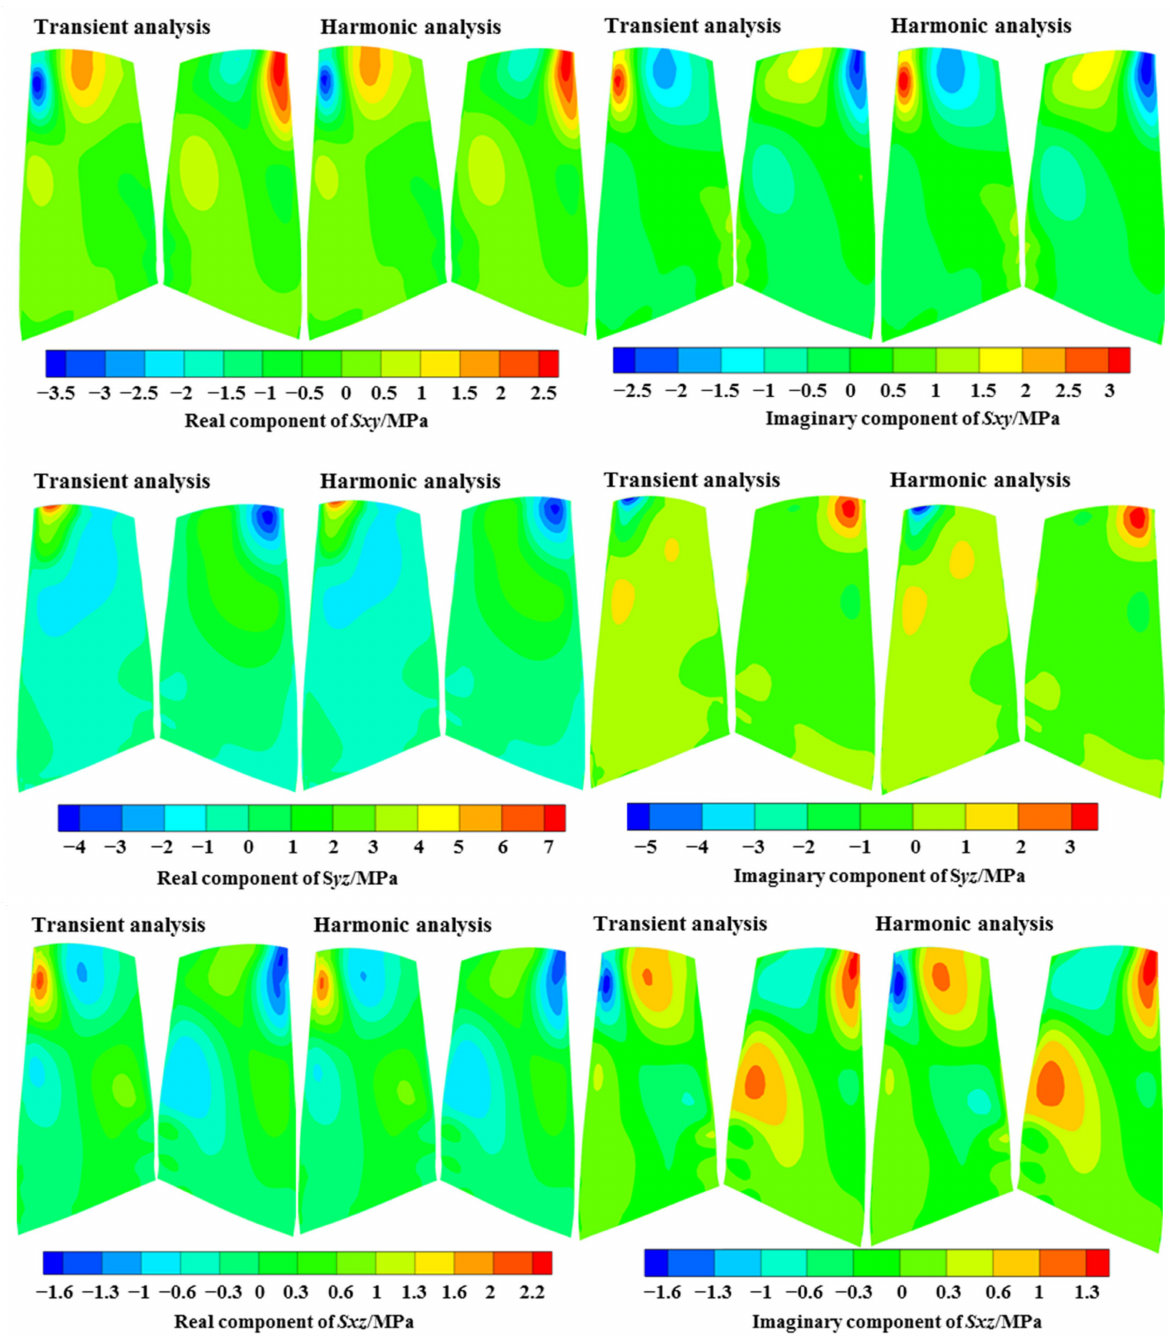
Figure 22. Comparison of the shear stress